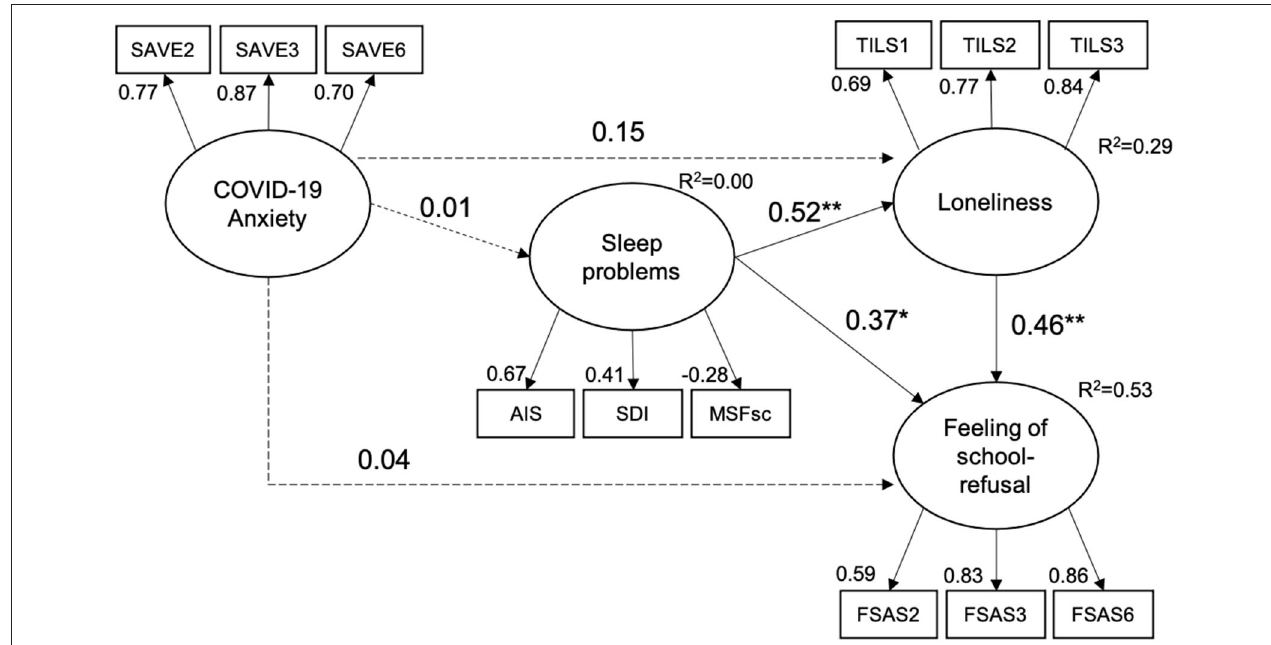
FIGURE 2 | Result of structural equation modeling. Solid lines indicate significant pathways. Dashed lines indicate non-significant pathways. * p < 0.05, ** p < 0.01.